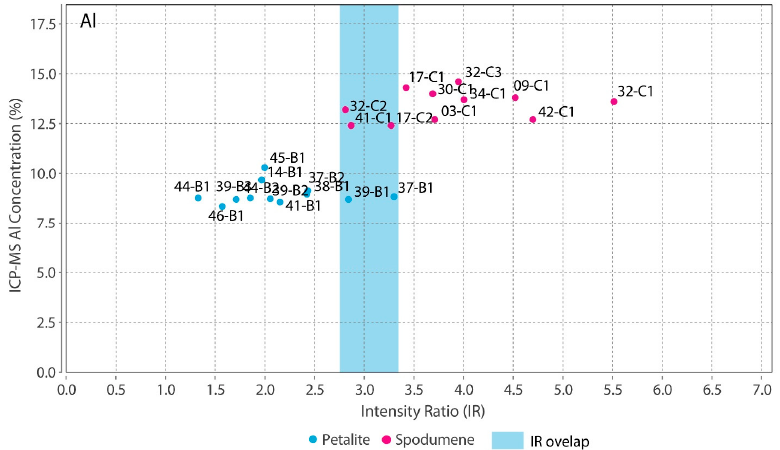
Figure 18. Overlap of the pLIBS Al intensity ratios for the spodumene and petalite samples of the Barroso–Alvão aplite-pegmatite field.